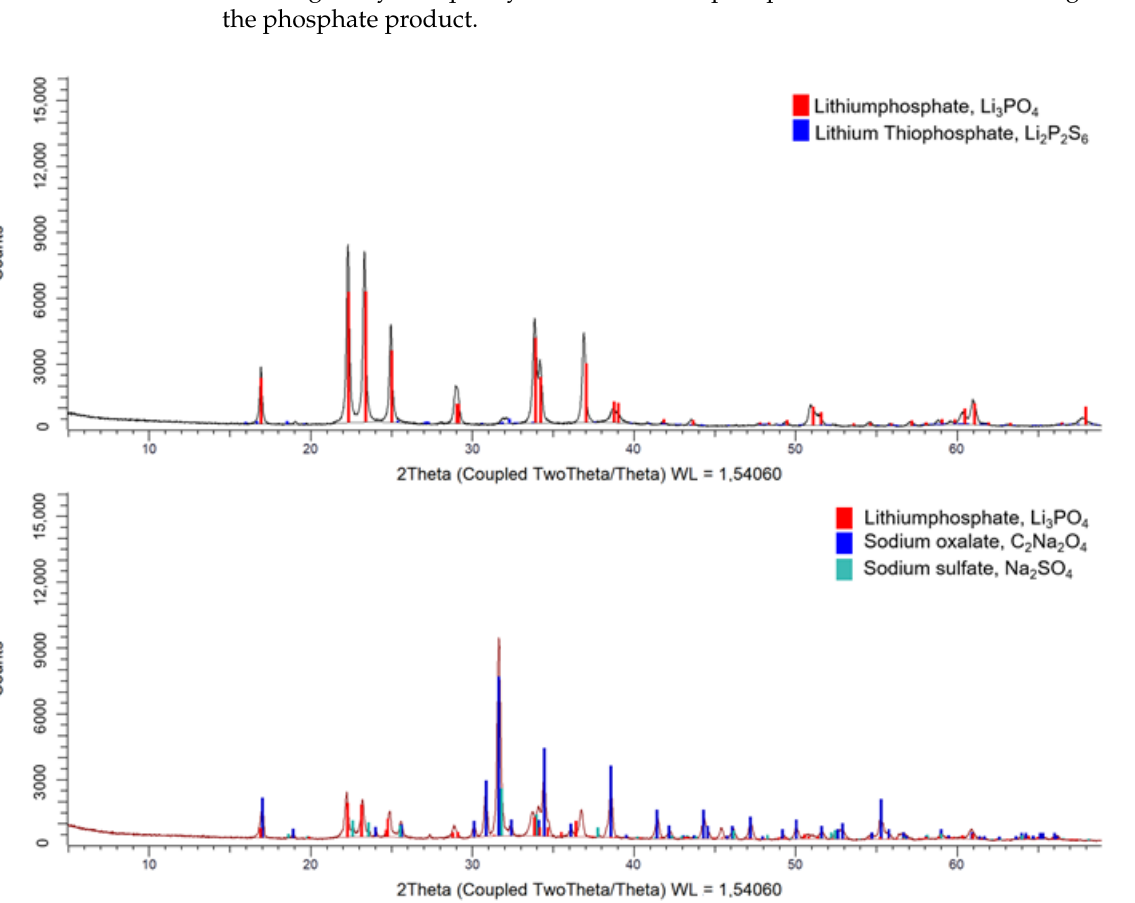
Figure 9. Diffractogram for the precipitation products of the synthetic ( top ) and authentic ( bottom ) starting solution using sodium phosphate as precipitant.